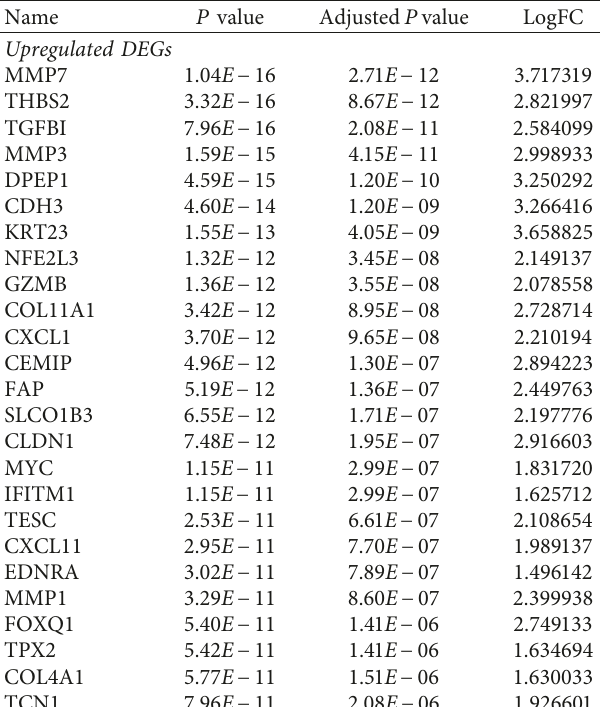
Figure 2: Coexpression network of hub genes. The hub genes in the red modules were filtered by a condition of the weight value ( > 0.15) and visualized using Cytoscape 3.6.0. The size and color of the edge represent the intensity of weight interaction in the network. Table 1: Whole DEGs (176 upregulated genes and 288 down- regulated genes) identified in the six microarray data from the GEO database by using adjusted P value < 0 . 01 and |logFC| ≥ 1 as the cutoff